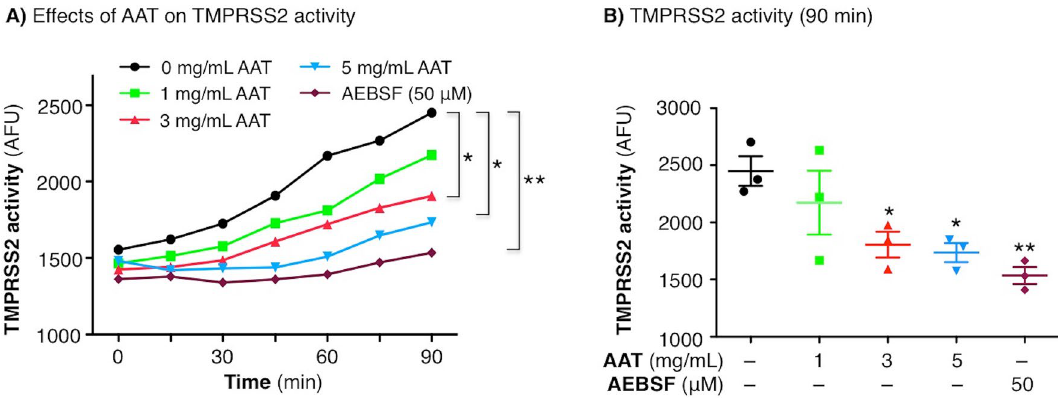
Figure 2. Activity of TMPRSS2 in the presence of AAT. ( A ) HEK293T TMPRSS2 cells were left untreated or pre- treated with AAT at the indicated final concentrations or AEBSF (50 µM) for 30 min, followed by addition of the fluorogenic substrate Boc-QAR-AMC. Fluorescence was measured immediately on the fluorescent plate reader and then every 15 min for a total of 90 min. ( B ) TMPRSS2 activity at 90 min. Data shown are the triplicate means ± SEM of three independent experiments. *p < 0.05, **p < 0.01 at 90 min compared to untreated cells. AAT = alpha-1-antitrypsin.